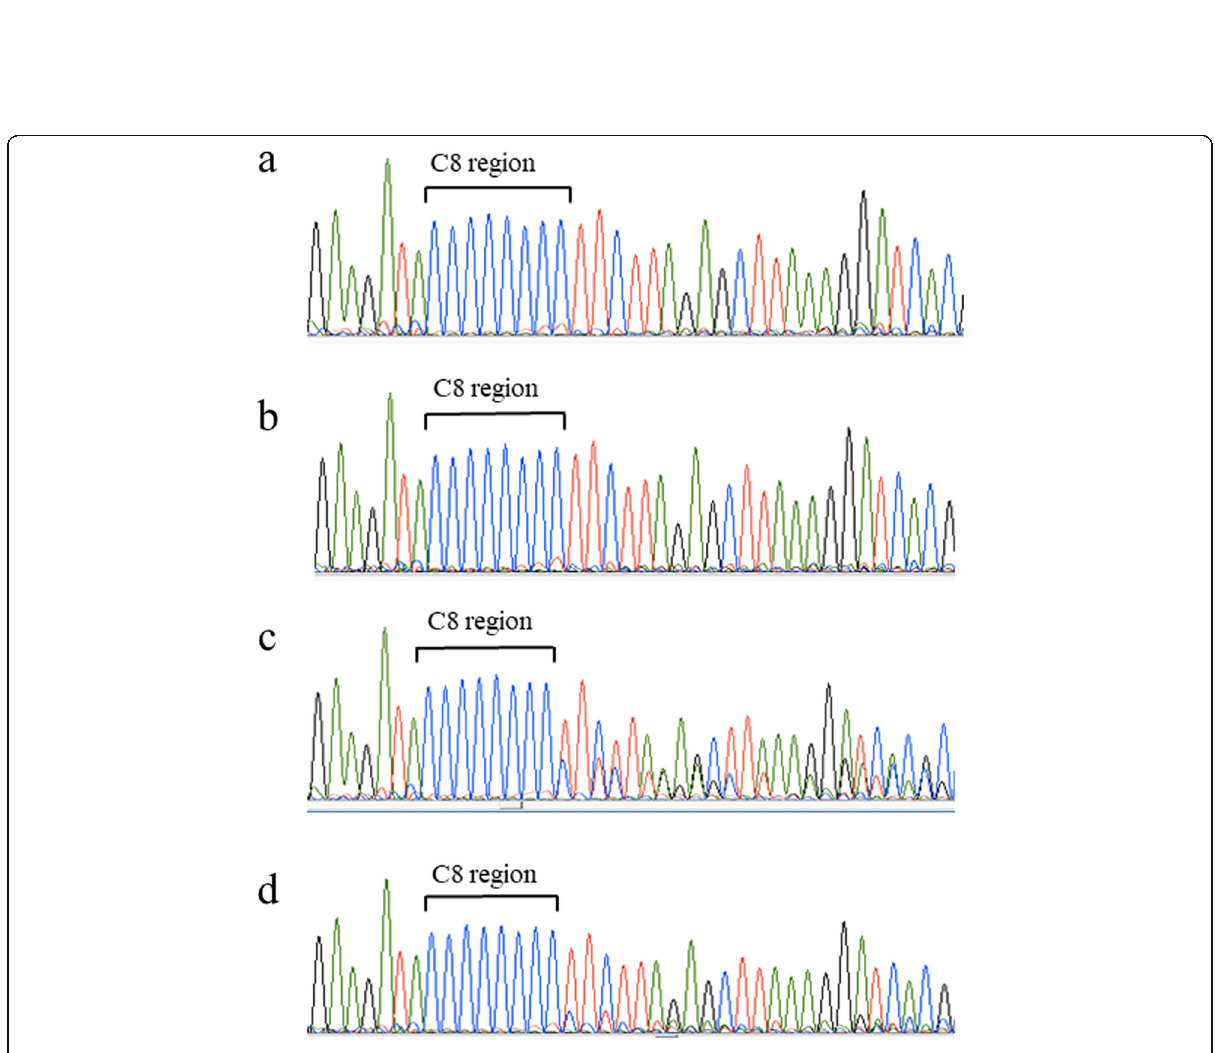
Fig. 4 Electropherograms depicting the coding region microsatellite (C)8 in exon 5 of MSH6 from this patient ’ s tumors. An intact (C)8 region was shown in a normal mucosa of the colon ( a ) and stomach cancer ( b ). An abnormal (C)8 region was detected in the colon cancer ( c ) and the liver metastasis ( d